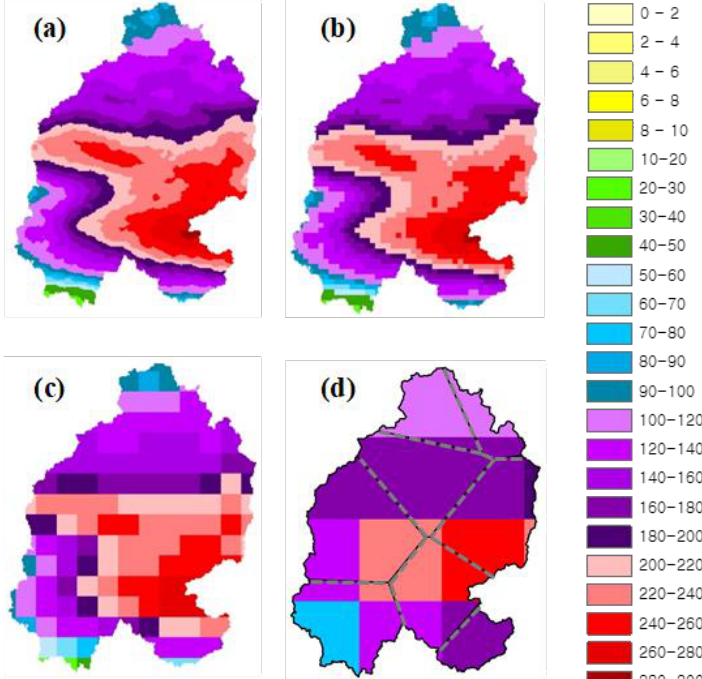
Figure 3. Rainfall distributions with various rainfall spatial resolutions (RSRs) during Event1: ( a ) L r = 250 m, ( b ) L r = 1 km, ( c ) L r = 4 km, and ( d ) L r = 16 km. Gray dashed lines in ( d ) represent the Thiessen network.